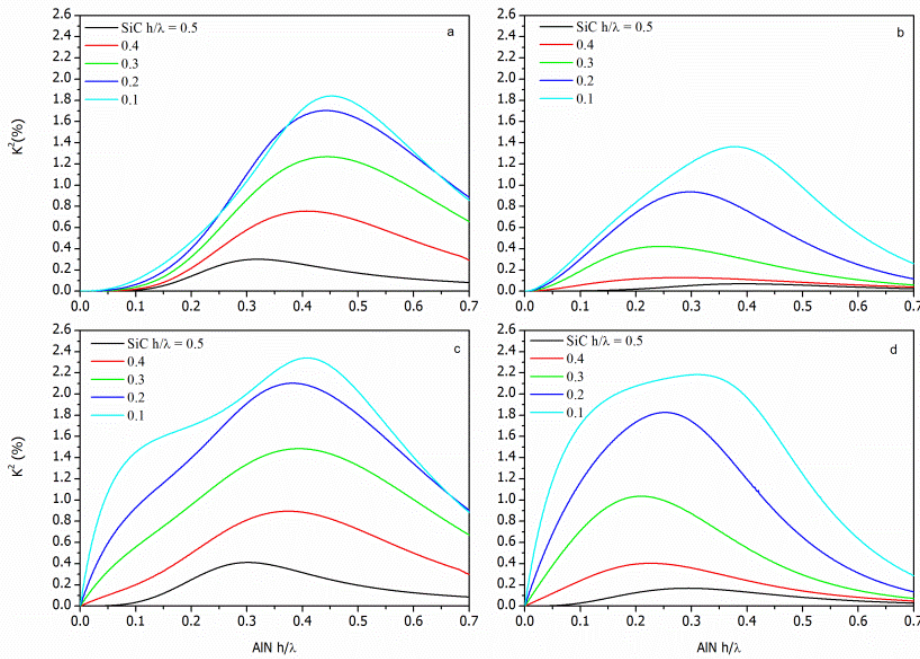
Figure 4. The K 2 dispersion curves of the ( a ) STF, ( b ) SFT, ( c ) STFM, and ( d ) SMFT coupling configurations on c-AlN/SiC(001)<100> substrates; the h/ λ the running parameter.